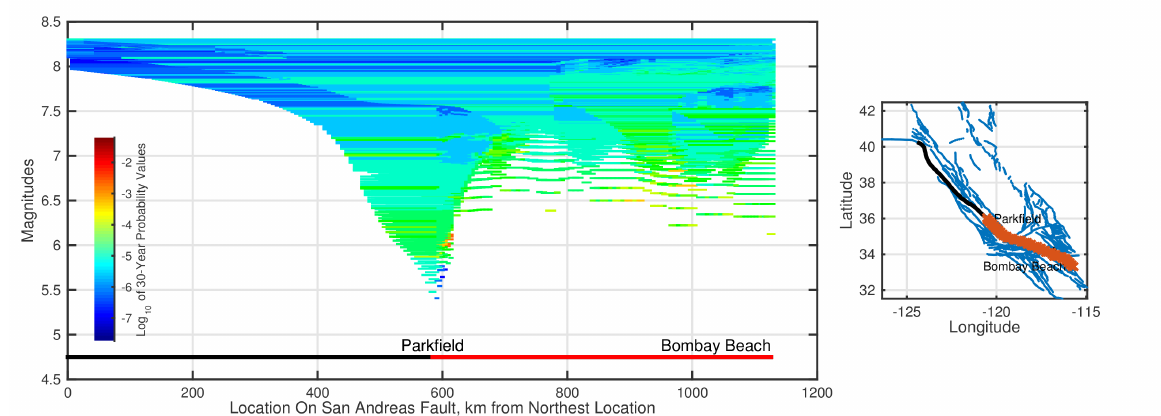
Figure 2. All plausible (or “forecast”) earthquakes that rupture at least one segment of the southern section of the San Andreas fault (from Parkfield in central California to Bombay Beach in southern California, shown in red). The X axis identifies the extent of rupture of a forecast earthquake and the Y axis identifies its magnitude. Line colors indicate forecast earthquake occurrence probabilities, with warmer colors (red, orange) indicative of higher probability of occurrence and colder colors (blue) indicative of lower probability of